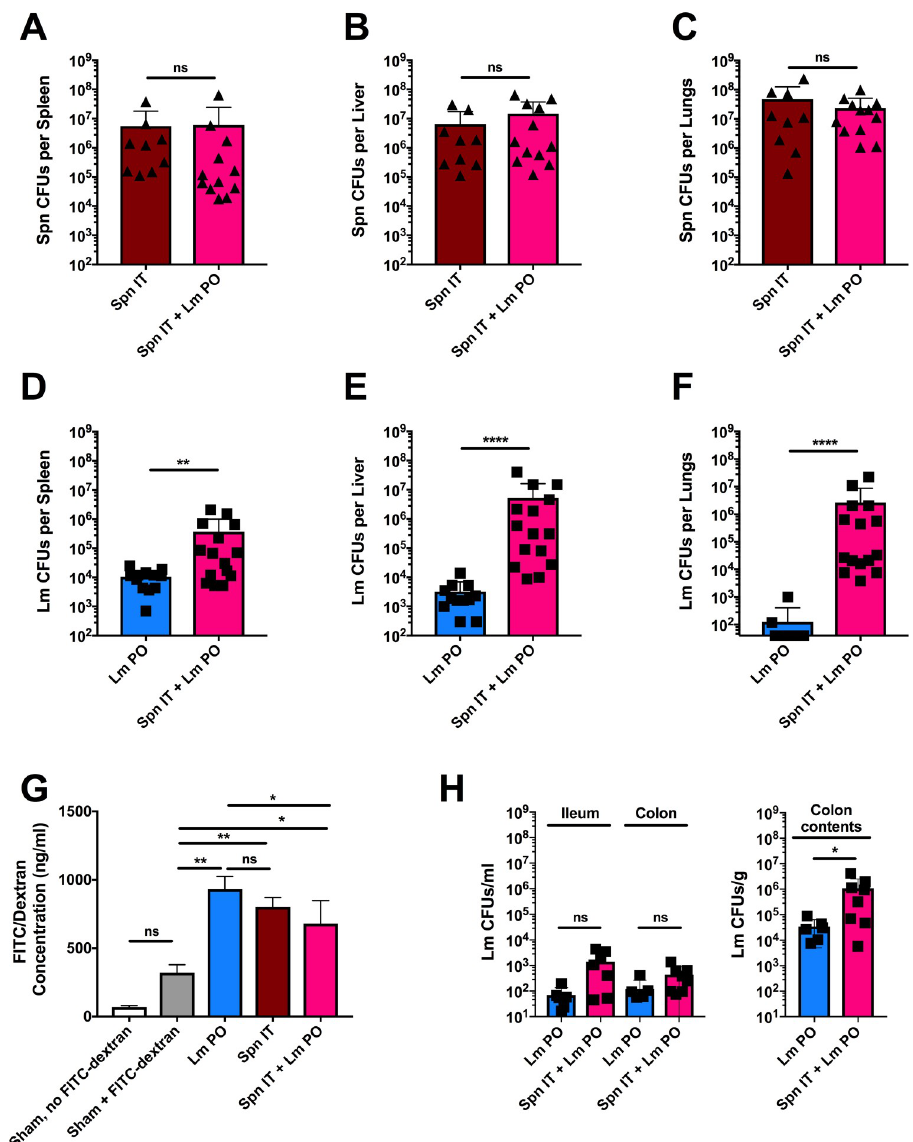
Fig 2. Pulmonary Spn coinfection increases susceptibility to oral Lm . C57BL/6J (B6) male and female age-matched mice were infected with sham control, Lm PO, Spn IT, or Spn IT + Lm PO, and CFUs were determined 3 dpi. Spn burdens were enumerated from (A) spleens, (B) livers, and (C) lungs, and Lm burdens were enumerated from (D) spleen, (E) livers, and (F) lungs. (A-F) Data are represented as mean ± SD, Mann-Whitney t-test, pooled from 3 experiments, with 9–15 mice per group, �� p < 0.002, ���� p < 0.0001 between indicated groups. B6 male and female age- matched mice were infected with sham control, Lm PO, or Spn IT + Lm PO, and gut permeability and CFUs were determined 1 dpi. (G) FITC-dextran was orally gavaged 4 hour before sacrifice, and upon sacrifice, blood was collected by cardiac puncture. Serum was measured for fluorescence, and the concentration was determined using a standard curve. Data represent mean ± SD, One-way ANOVA, pooled from 2 experiments, 4–8 mice per group, � p < 0.05, �� p < 0.002 between indicated groups. (H) Intestinal Lm CFUs were measured from the ileum, colon, and in the colon contents. Data represent mean ± SD, Mann-Whitney t-test, pooled from 2 experiments, 6–8 mice per group, � p < 0.05 between indicated